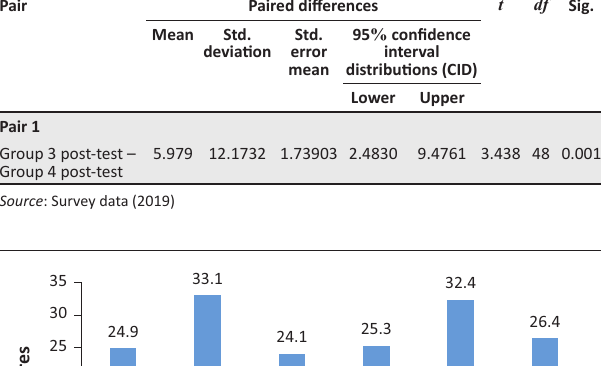
TABLE 3: Paired samples test. Pair Paired differences t df Sig. Mean Std. Std. deviation error